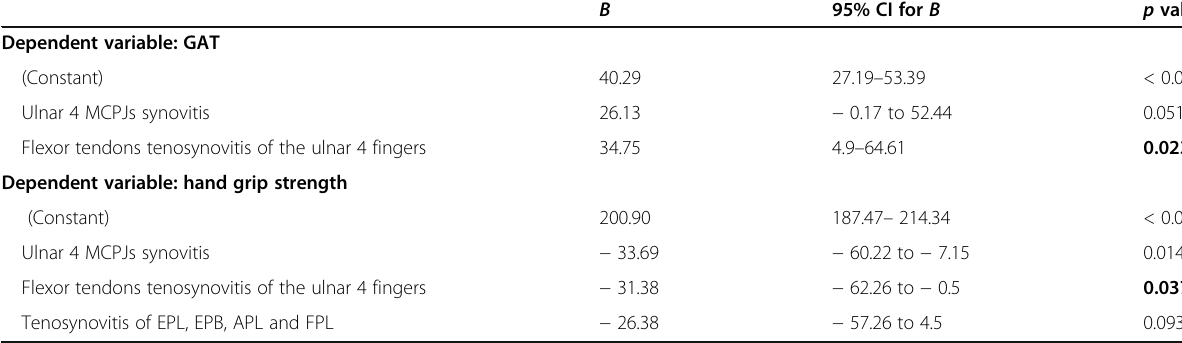
Table 4 Multiple regression model for analyzing the factors influencing GAT and hand grip